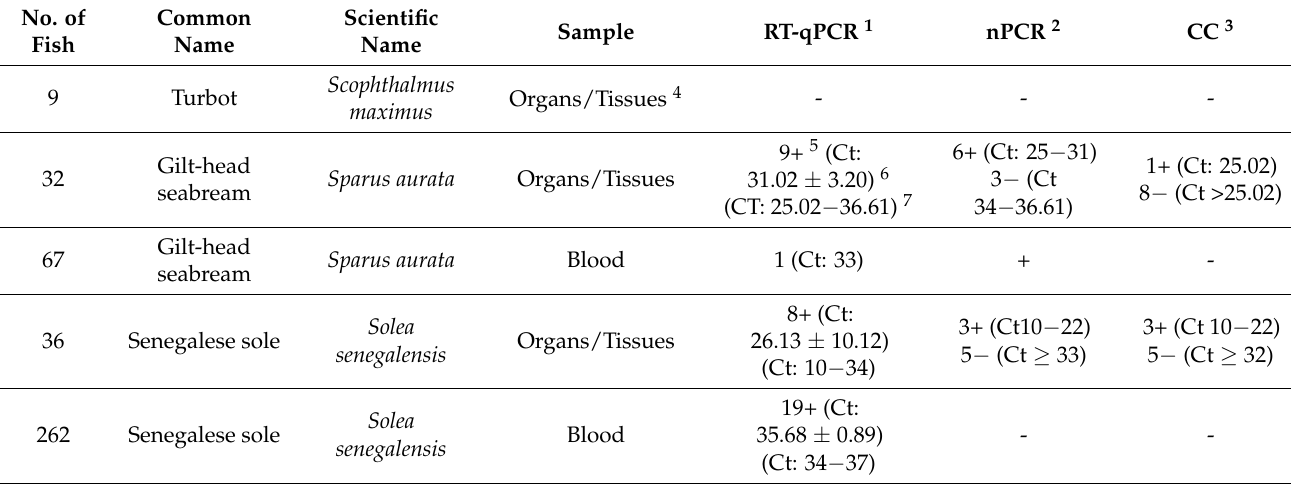
1 The RT-PCR procedure assayed in the present study; 2 the nested polymerase chain reaction (nPCR) evaluated in a previous report [22]; 3 cell culture isolation; 4 organs/tissues: brain and/or kidney, spleen, and heart; 5 number of VNNV positive or negative samples; 6 average threshold (Ct) ± standard deviation; 7 Ct